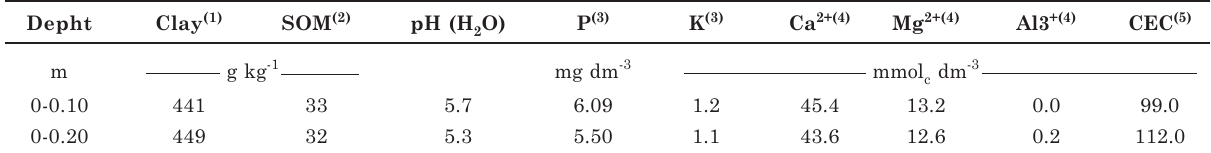
Table 1. Characterization of soil fertility at begins of the experiment, in two soil layers